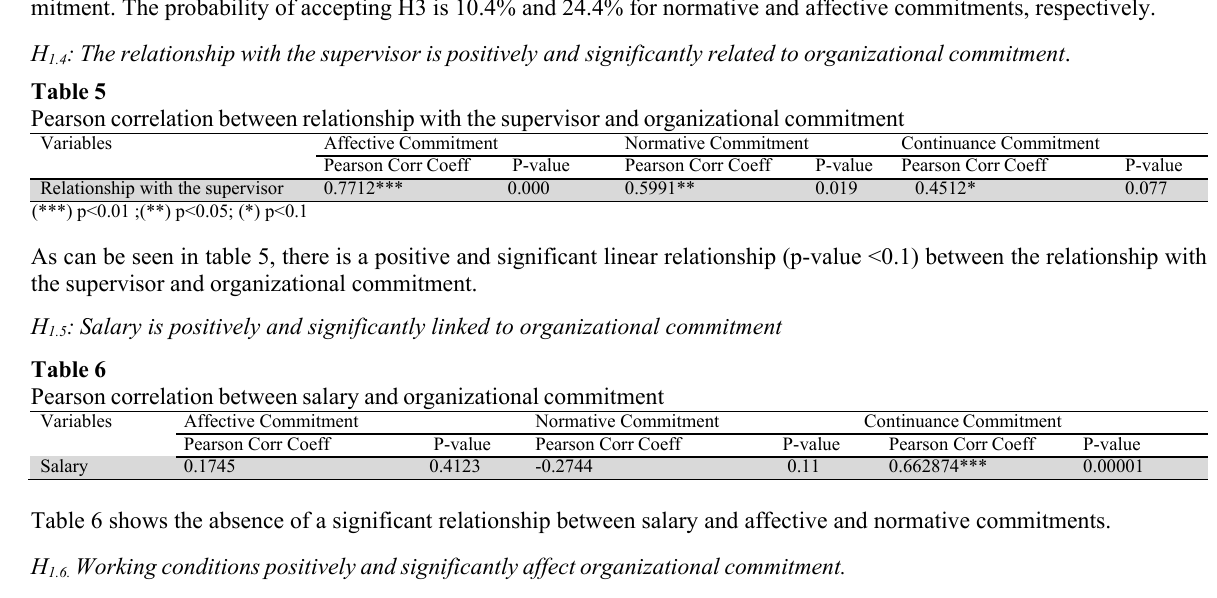
Pearson correlation between working conditions and organizational commitment Variables Affective Commitment